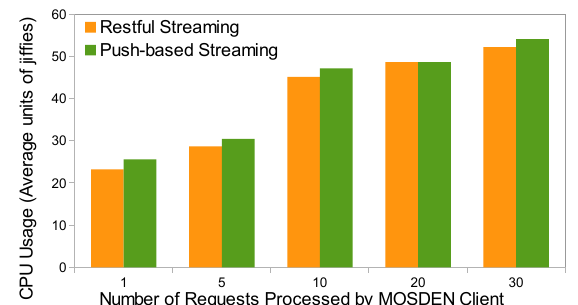
Figure 10. Comparison of CPU Usage by MOSDEN Client -